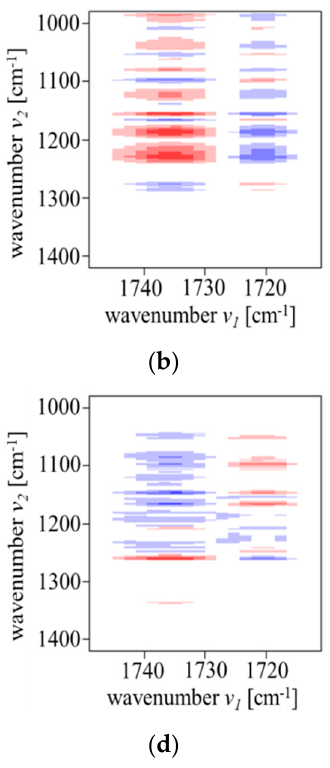
Figure 11. 2D-COS correlation ( a , b ) synchronous and ( c , d ) asynchronous maps of 3F7HPhH7 in the heating mode from 249 to 299 K in the wavenumber regions of: ( a , c ) 1750–1710 cm –1 vs. 3000–2840 cm –1 and ( b , d ) 1750–1710 cm –1 vs. 1400–1000 cm –1 . The red or blue areas represent positive or negative correlation intensities, respectively.